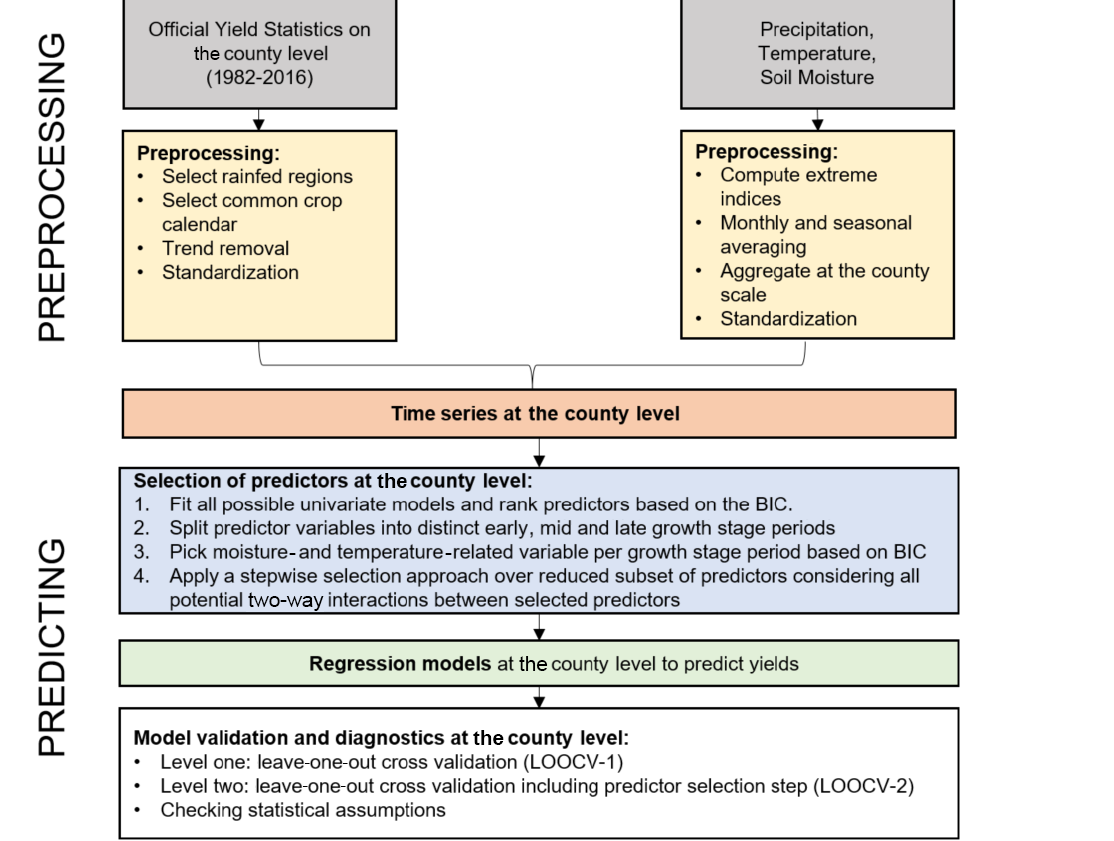
Figure 2. Overall modelling workflow applied for this study, linking US yields to weather and climate